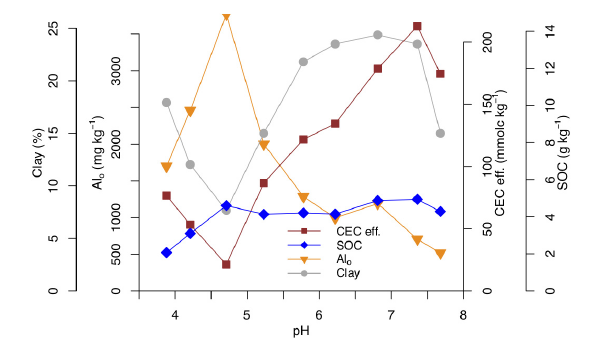
bridge negatively charged organic compounds together,